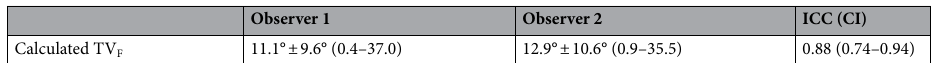
Table 5. For inter-observer reliability analyses, measurements of two observers of calculated TV F were compared using the ICC. Measurements are demonstrated as mean ± SD and range. The ICC is shown with the 95% confidence interval